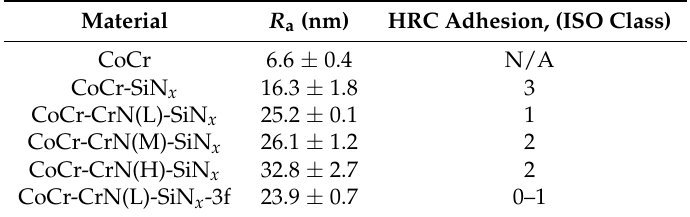
Table 2. Surface roughness and adhesion of the investigated